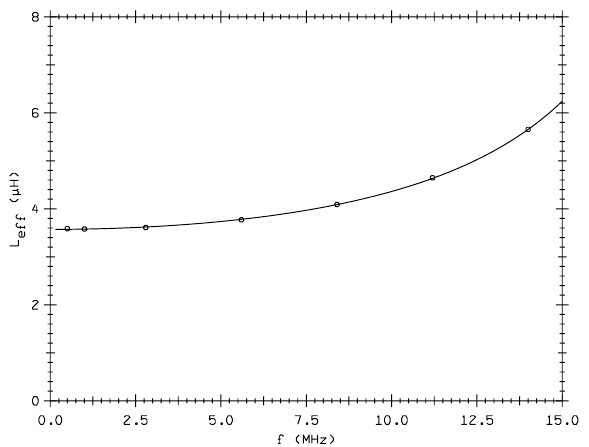
FIG. 7. Dependence of effective inductance on frequency for one inductive cavity with zero bias current. Measured data are indicated by circles. The solid curve is a fit to the data using a TEM-mode resonance expression.